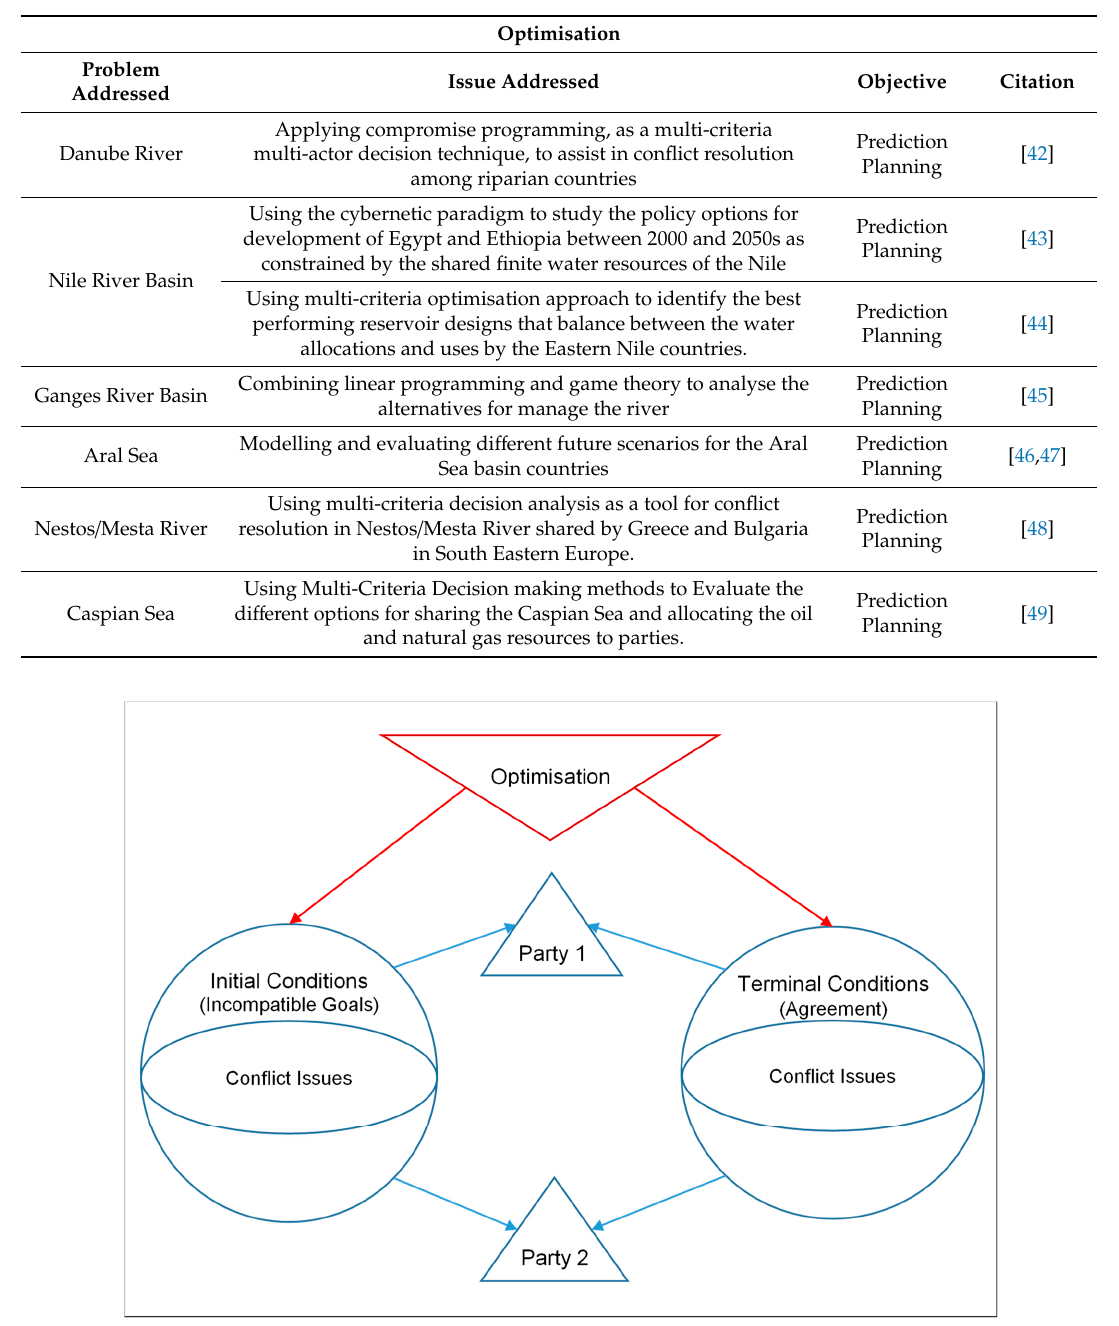
Figure 2. Structure of Optimization Modelling Mechanism. Table 1. Static Models—Theory and Implementation.